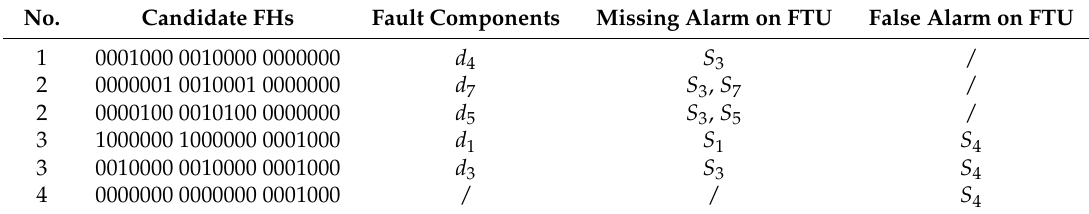
Table 5. Diagnosis using the upper-level analytic model in scenario 3.